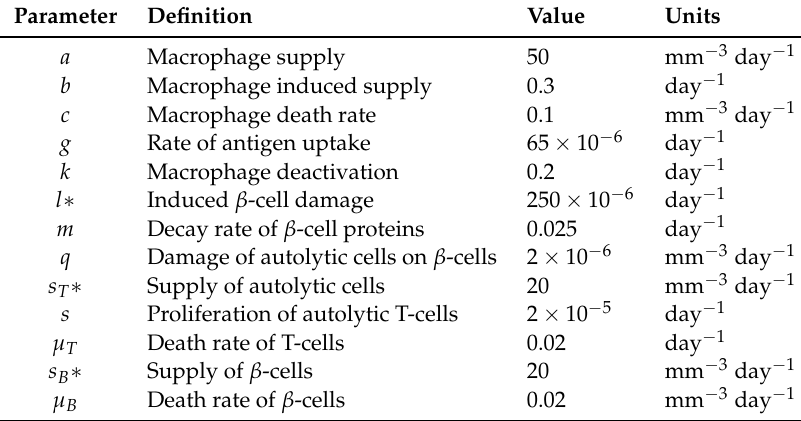
Table 1. Parameter descriptions, values, and